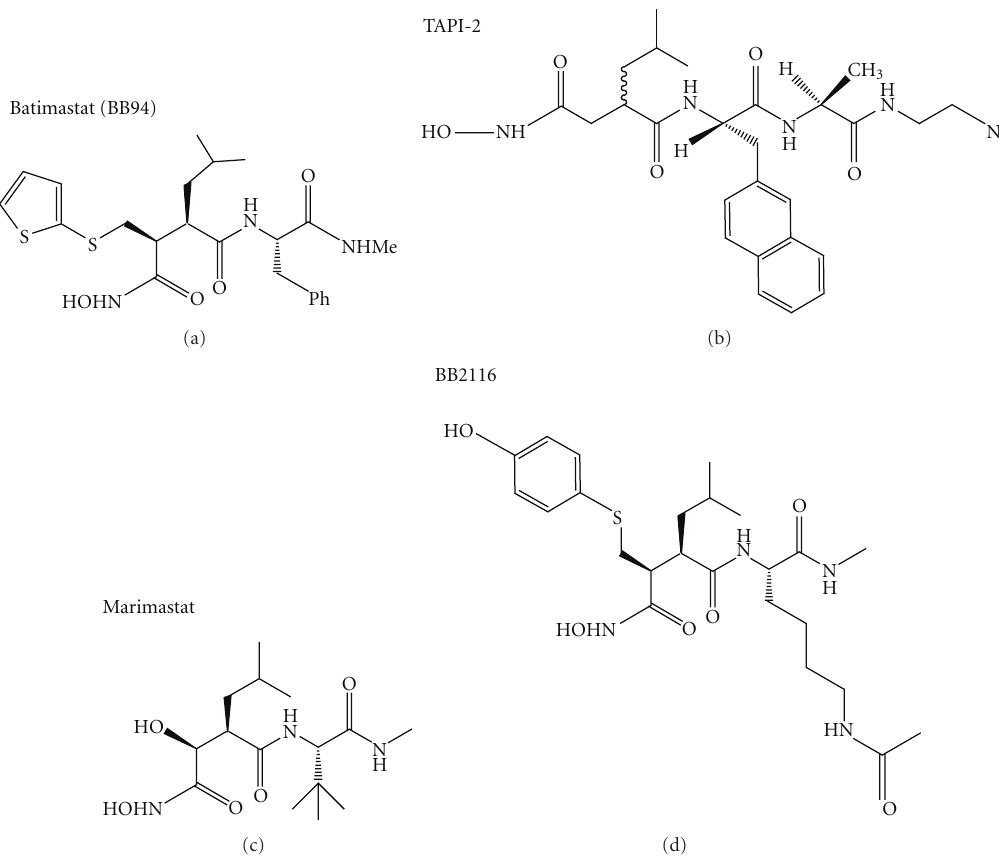
Figure 2: Structures of hydroxamic acid-based zinc metalloproteinase